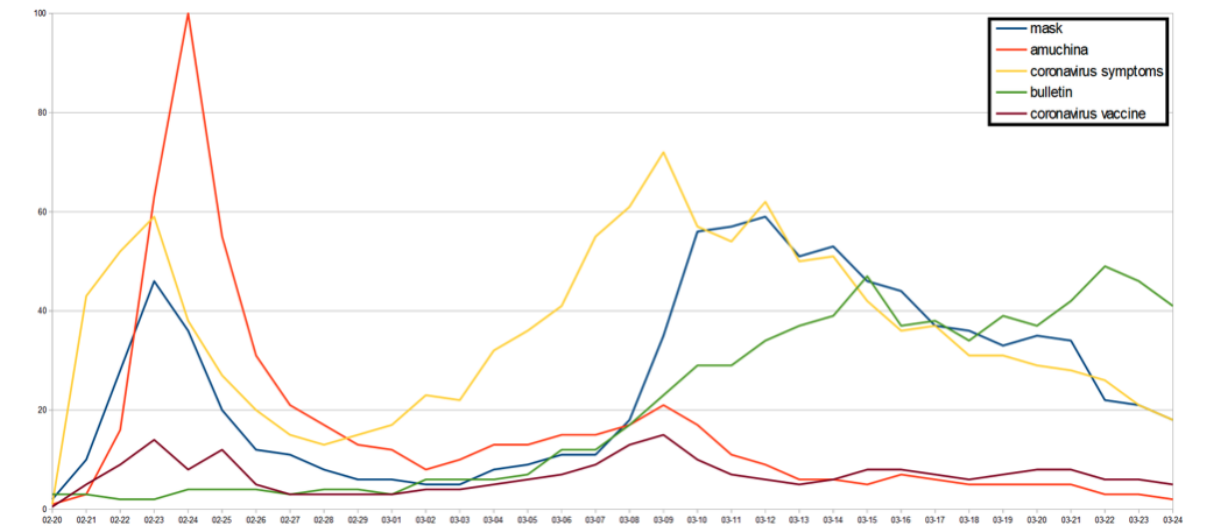
Figure 2. The top five searches related to